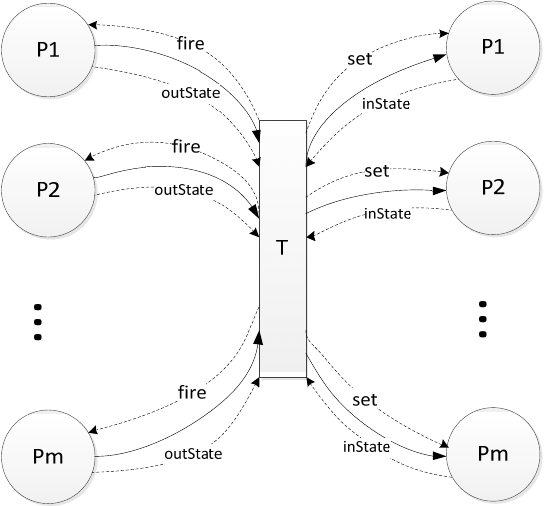
Figure 12: The input and output connector variables of